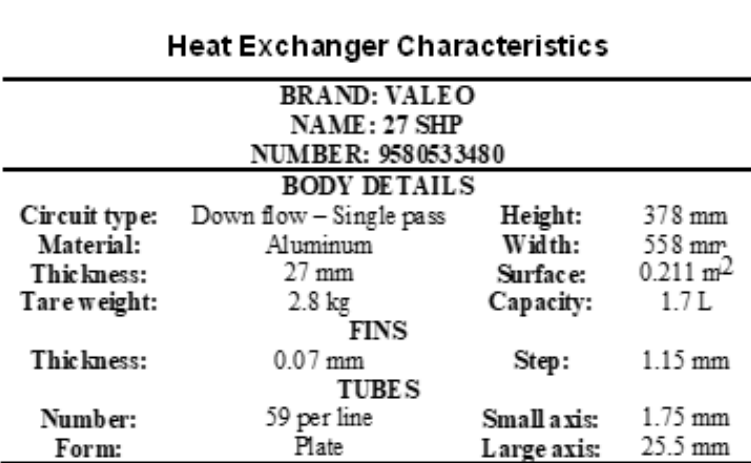
Figure 8. Structure and characteristics of the heat exchanger used in the experiment.